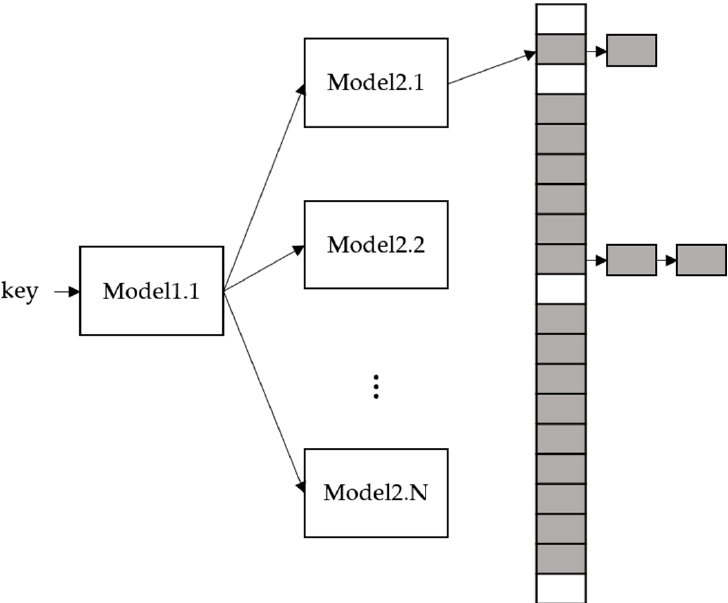
Figure 3. Learned Hash-Map [7]: The top-level model received the key as an input and it predicts the final position in the leaf model.